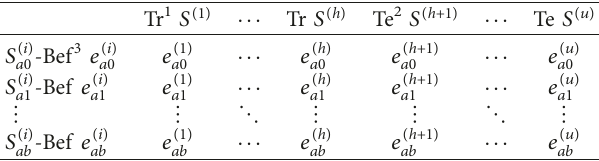
Table 2: Bearing feature score